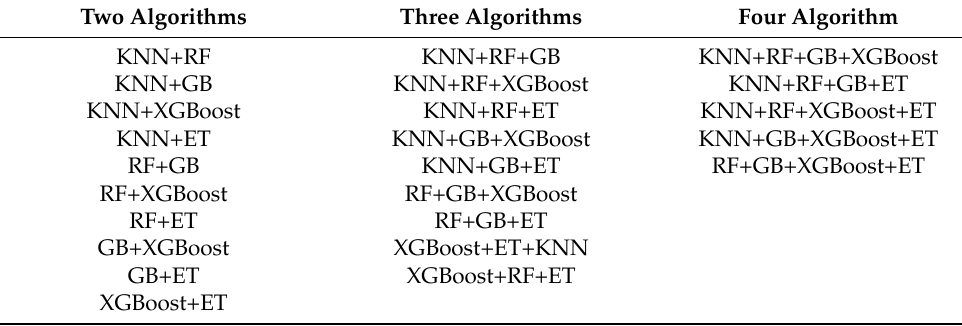
Table 3. Ensemble combinations.